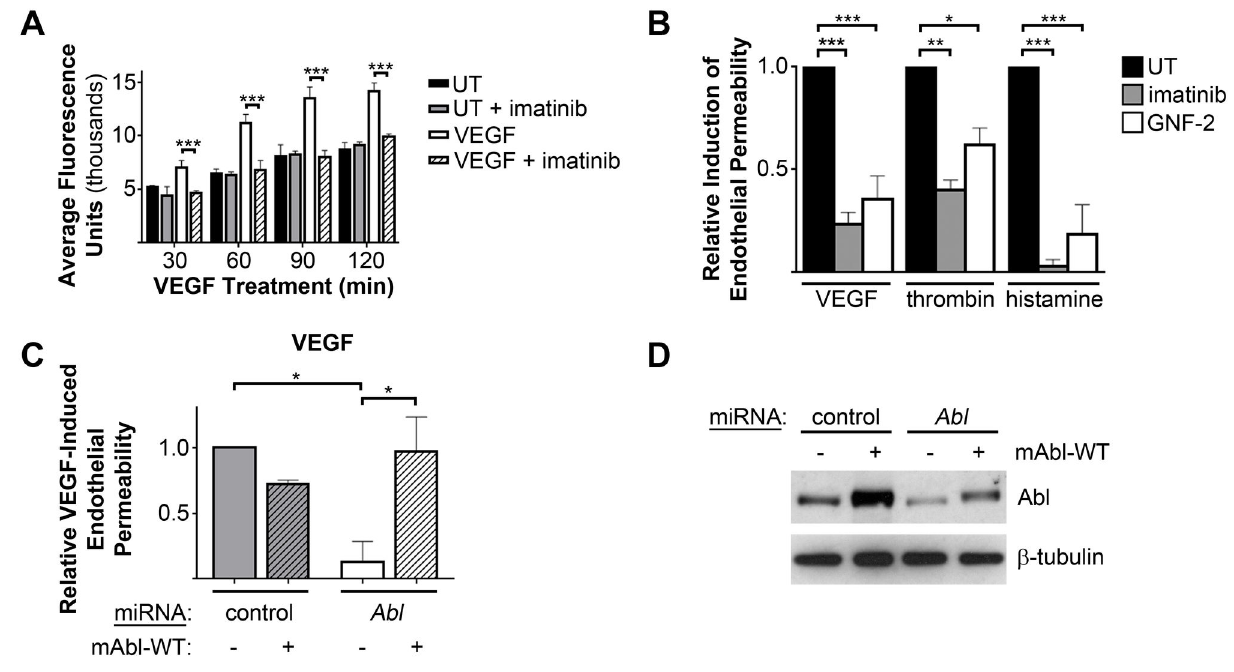
Figure 2. Loss of Abl kinase function decreased endothelial barrier dysfunction in vitro . ( A ) Evaluation of endothelial monolayer permeability, as assessed by passage of fluorescein-labeled dextran (molecular weight 40kDa) through HMVEC monolayers grown on Transwells, following treatment with VEGF (100ng/mL) with or without imatinib pre-treatment (10μM). Data shown are mean fluorescence of samples collected from bottom Transwell chambers at the indicated times post-VEGF treatment, +/- SD of three replicates per treatment. Data are representative of 3 independent experiments. ( B ) Quantification of inhibition of endothelial monolayer permeability to fluorescein-labeled dextran by imatinib (10μM) or GNF-2 (15μM). Endothelial barrier dysfunction was induced by treatment of HMVECs with VEGF (100ng/mL, 120 minutes), thrombin (1U/mL, 30 minutes) or histamine (100μM, 60 minutes). Values are expressed relative to permeability induction in vehicle-treated cells (UT). Data are presented as means +/- SEM (n=3). ( C ) Quantification of VEGF-induced endothelial permeability of HMVECs expressing either control or Abl miRNAs, with or without re-expression of miRNA-resistant, wild-type murine Abl (mAbl-WT). Values are expressed relative to VEGF-induced permeability in control miRNA-expressing cells. Data are presented as means +/- SEM (n=3). ( D ) Assessment of Abl protein levels following miRNA expression in HMVECs, with or without re-expression of miRNA-resistant Abl. *P<0.05; **P<0.01;